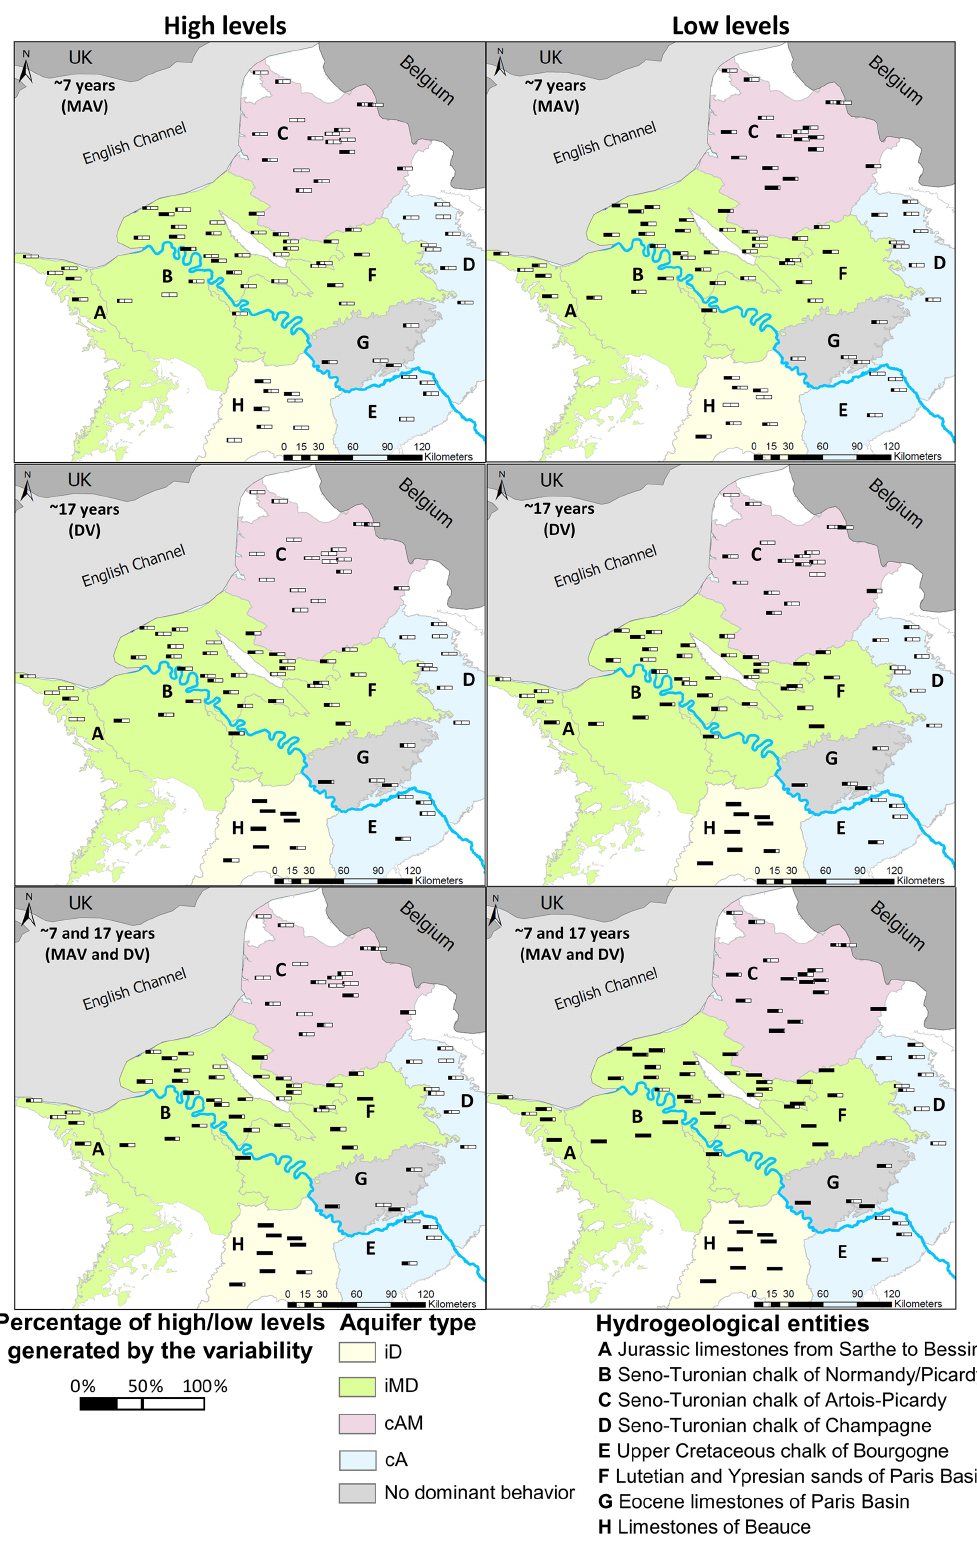
Figure 8. Percentage of HLs or LLs generated by the ∼ 7-year (MAV), ∼ 17-year (DV), and ∼ 7- and ∼ 17-year components in hydrogeo- logical entities of the Paris Basin. This percentage corresponds to the proportion of HLs or LLs that are not considered to be extreme levels (being respectively below or above the threshold) when the component(s) is (are) absent from the original signal, meaning that these HLs or LLs are significantly supported by the